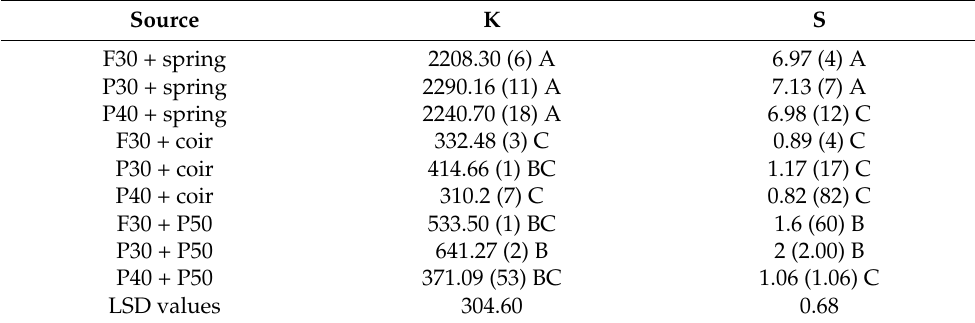
Table 5. Mean K and S Values of the mattresses evaluated in this study.